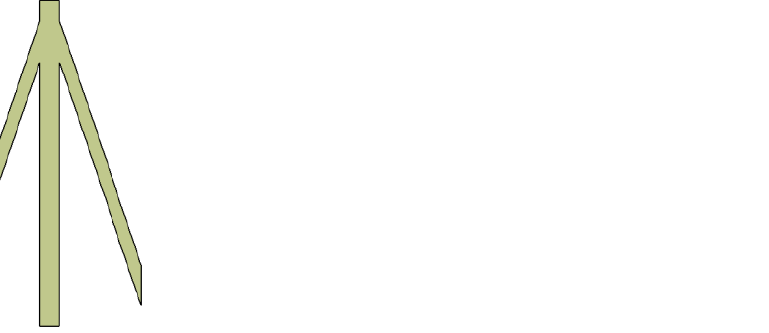
Figure 26. The plane shape of the optimized accordion honeycomb unit.